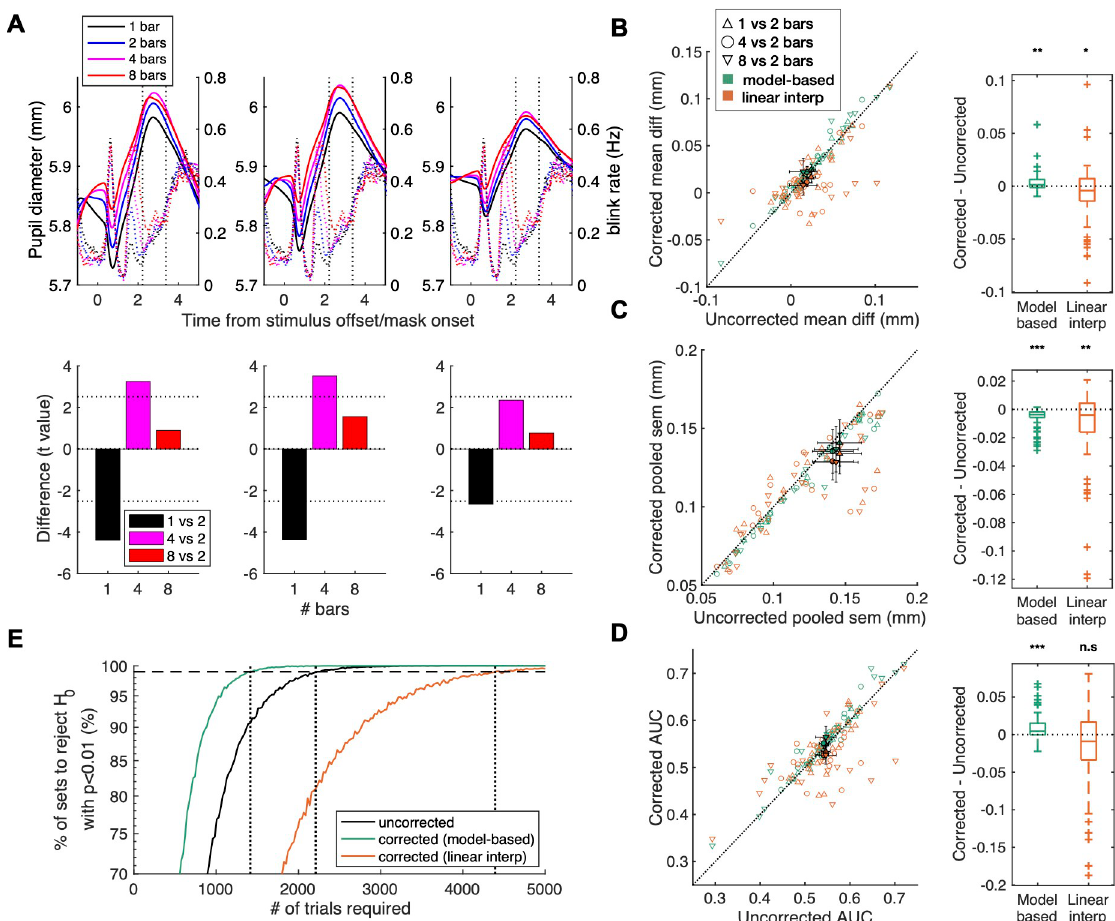
Fig 9. Contribution of BPR correction to the statistical power of the delayed orientation estimation task. ( A ) (top panels) Pupil (solid line) and blink rate (dotted line) time course across the working-memory load conditions. The time 0 is the onset of the mask epoch. The pupil size increased as a function of working-memory load. The color indicates the number of bars to be memorized (N = 1,2,4 and 8 are denoted as black, blue, magenta, and red lines, respectively). Solid lines indicate the means across subjects, and the vertical dotted lines indicate the time span where the mean pupil of each trial is computed. Note that the more memory load is given, the higher the blink rate was, and thereby BPR would be more biased to the higher memory load conditions. The model-based method captured this bias so that the pupil-size time course under high memory loads increased more than low memory loads after the correction. (bottom panels) T values of the paired t-tests (df = 20) for the difference of each bar condition from the 2-bar condition. The left panel shows the results before correction; the middle and right panels show the results after being corrected using the model-based method and the interpolation method, respectively. ( B-D ) (left panels) Diagonal plot. Each marker indicates each condition pair, a subject has three markers each (1 bar vs 2 bars, 4 bars vs 2 bars, and 8 bars vs 2 bars). Filled marker and error bars indicate the mean and SEM across subjects. Empty markers correspond to individual subjects, with different colors indicating different correction methods (green for the model-based method; orange for the interpolation method) and different symbols indicating different working-memory load (the number of bars) pairs (see inset for detailed labels). (right panels) Boxplot. Corrected–uncorrected, which are equivalents to deviance from the diagonal line in the corresponding left panels (Wilcoxon signed-rank test, ( � , p < 0.05; �� , p < 0.01; ��� , p < 0.001)). The color scheme matched that shown in the left panels. ( B ) Mean difference in pupil dilation, ( C ) pooled SEM, ( D ) AUC between the conditions. Panel B and C were zoomed in for clear visualization. See S2 Fig for zoomed-out plots. ( E ) Effects of the correction methods on statistical power in the delayed orientation estimation task. The number of trials required to reject the null hypothesis decreased by about 40% by the model-based method, whereas it increased 100% by the linear interpolation